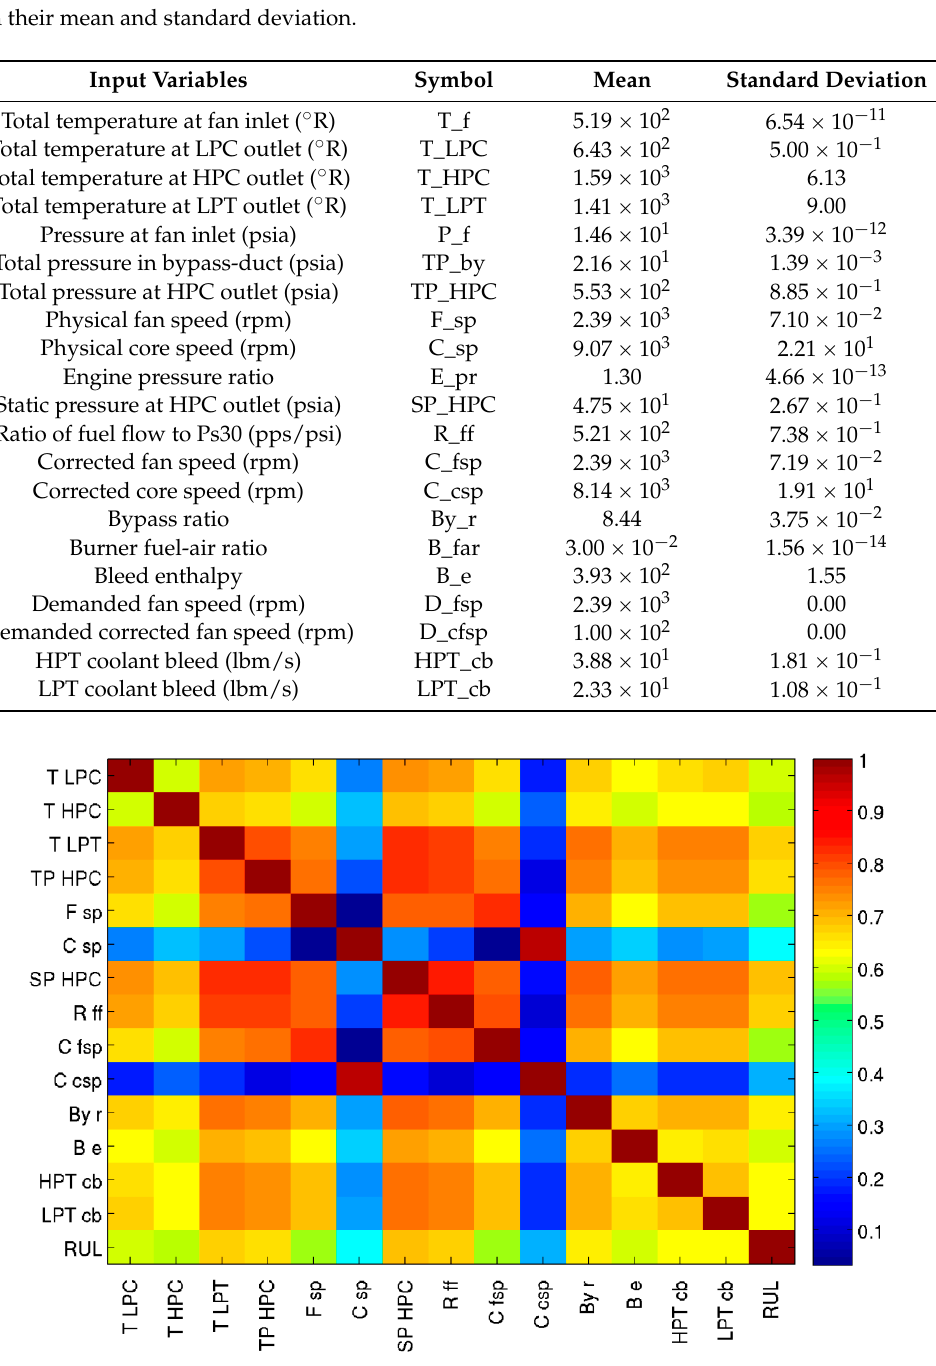
Figure 3. Correlation matrix of this problem with the two discarded independent variables: Physical core speed (C_sp) and Corrected core speed (C_csp).